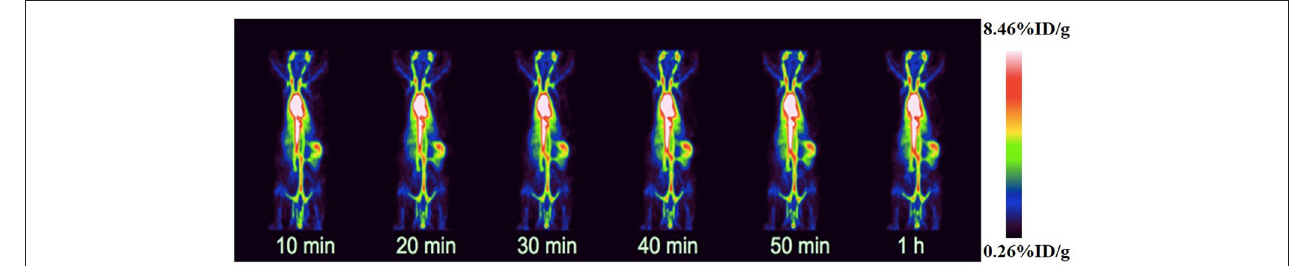
FIGURE 3 | Dynamic scan of normal rats using micro-PET/CT after injection with 18 F-VS-RBCs.